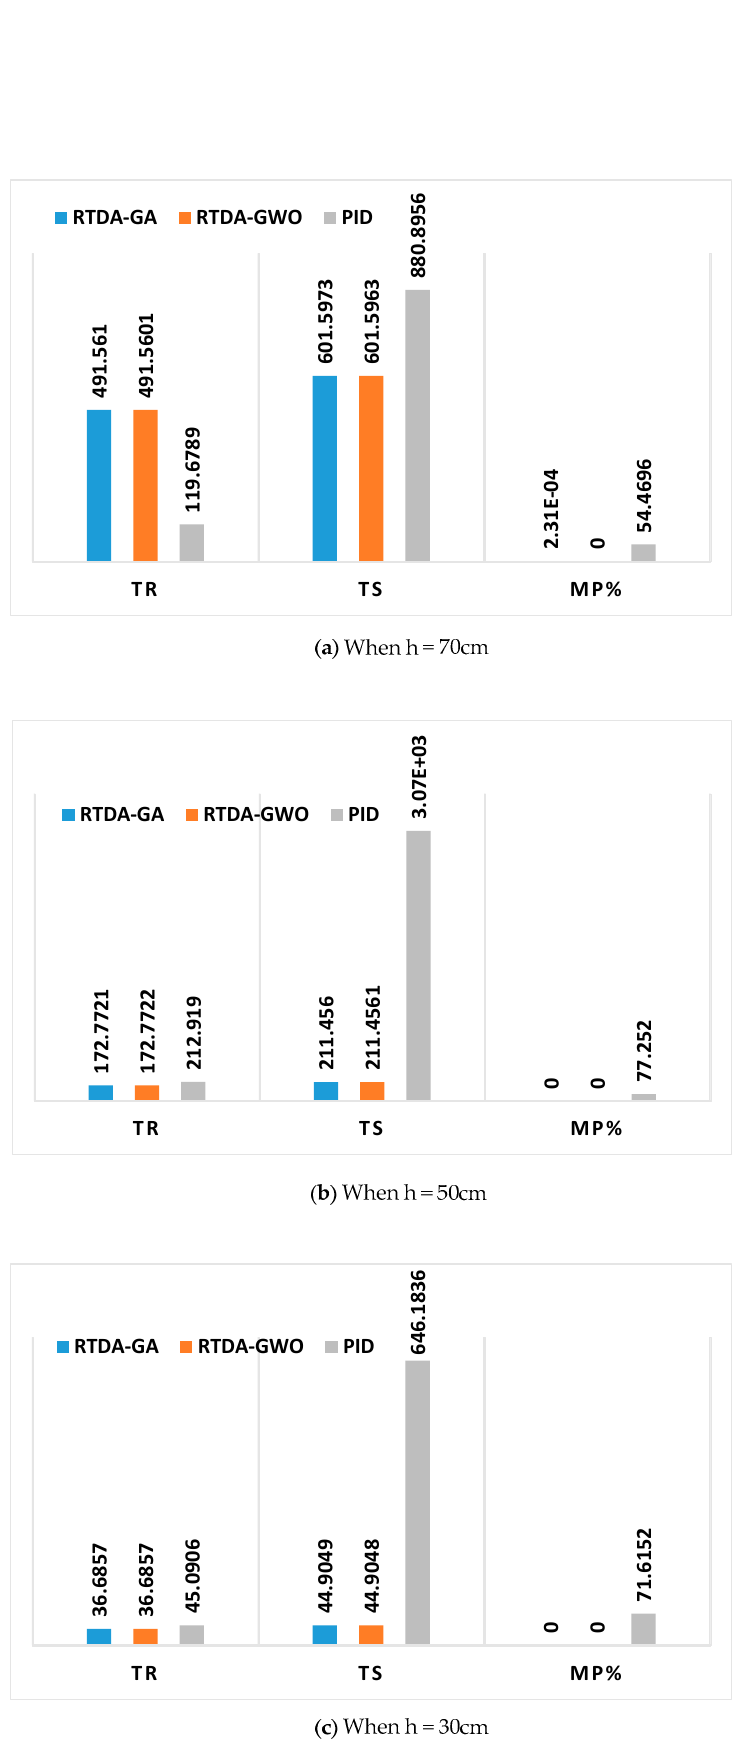
Figure 13. Case-2 Performance Comparison between RTD-A and PID: ( a ) when h = 70 cm; ( b ) when h = 50 cm; ( c ) when h = 30 cm .